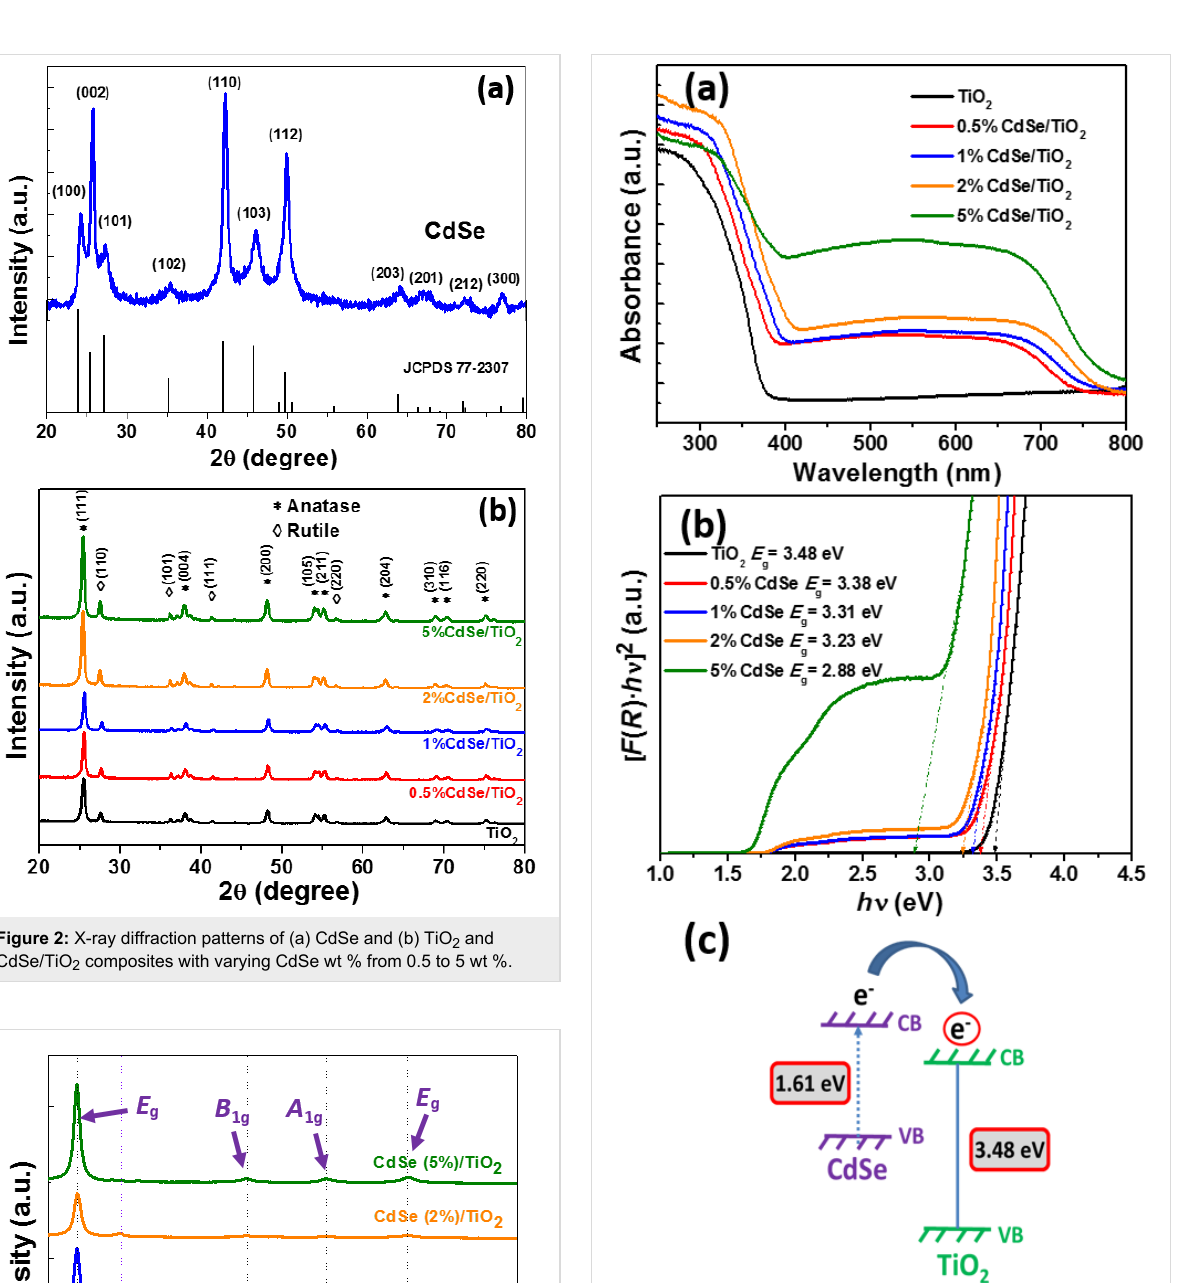
response in the visible region could be detected for TiO 2 due to its wide bandgap (3.48 eV). As can be seen, the absorption in- creases with the increase of CdSe NRs in the composite from 400 to ≈ 725 nm, which corresponds to the energy bandgap of CdSe NRs ( ≈ 1.61 eV) – a value slightly lower than the stan- dard bandgap of CdSe (1.78 eV) [47]. This enhanced visible light absorption originates from the excitation of CdSe NRs and indicates a decrease of the bandgap with increasing amount